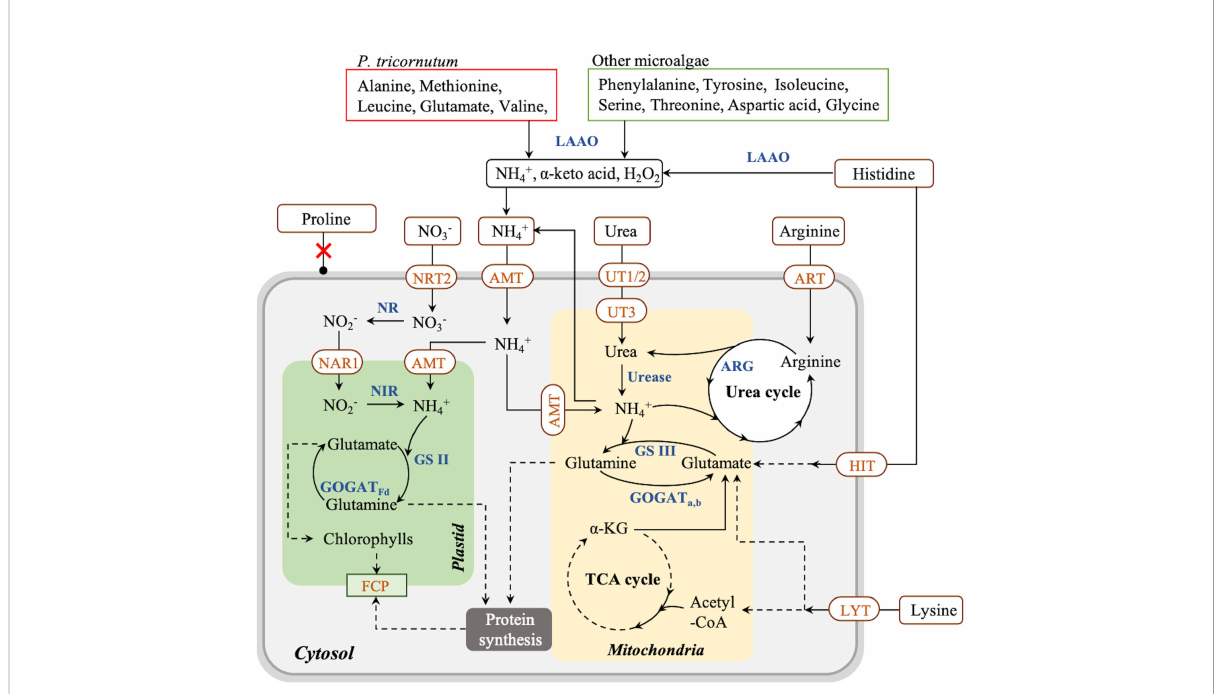
FIGURE 3 Proposed pathway of nitrogen assimilation in Phaeodactylum tricornutum and other microalgae. Solid arrow lines represent the direct reactions between the metabolites, and dash arrow lines represent the multistep reactions between those metabolites. Red boxes represent the amino acids consumed via LAAO by P. tricornutum ; green boxes represent the amino acids consumed via LAAO by other microalgae. NRT, nitrate transporter; NAR, nitrite transporter; NR, nitrate reductase; NIR, nitrite reductase; GS, glutamine synthetase; GOGAT, glutamine 2-oxoglutarate aminotransferase; AMT, ammonium transporter; UT, urea transporter; ART, arginine transporter; ARG, arginase; HIT, histidine transporter; LYT, lysine transporter; LAAO, L-amino acid oxidase; FCP, fucoxanthin – chlorophyll – protein